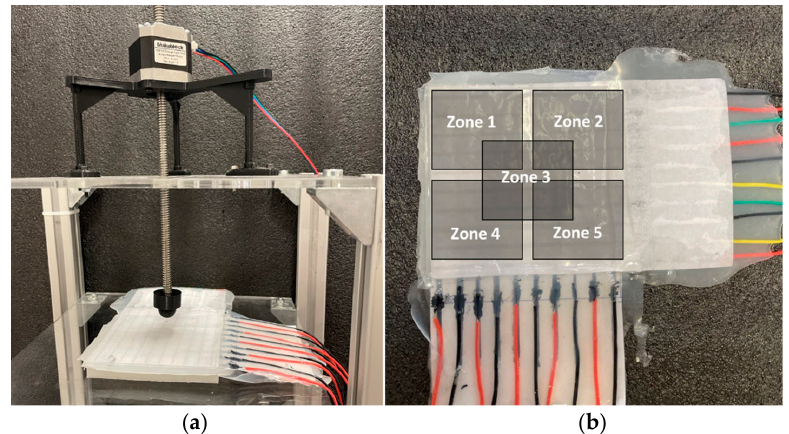
Figure 6. Setup for operating different tactile tests: ( a ) Attaching different probe sizes to the stepper motor for applying normal force and ( b ) dividing the sensor into five test zones to investigate the sensor performance.